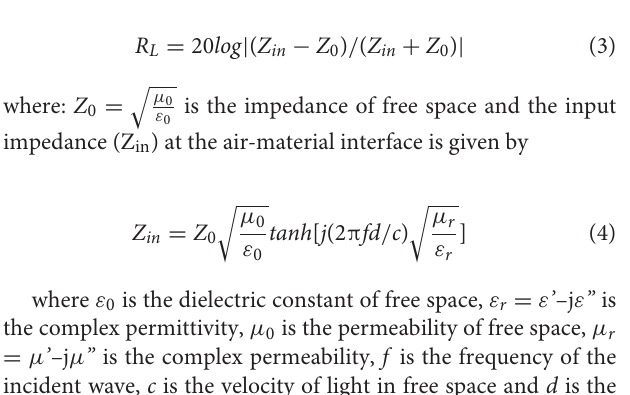
4). This can be quantified by reflection loss (Equation 2).